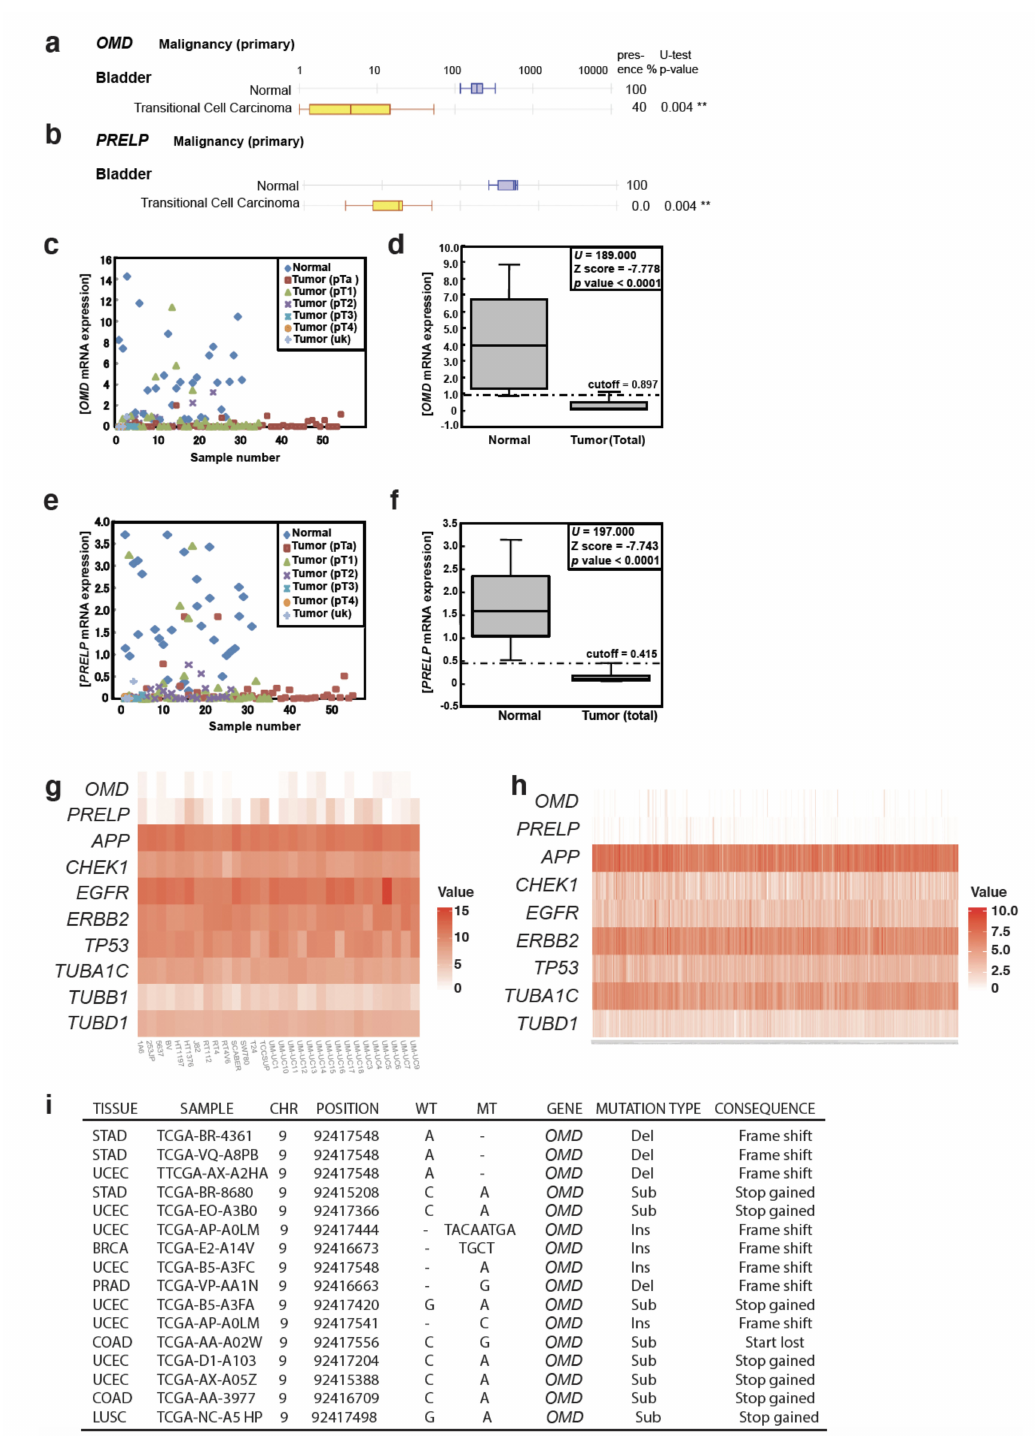
Figure 1. Expression of osteomodulin (OMD) and proline / arginine-rich end leucine repeat protein (PRELP) in cancer ( a , b ). Microarray analysis of OMD ( a ) and PRELP ( b ) expression in human bladder cancer samples and normal bladder tissues. ( c ) Quantitative analysis of OMD expression in bladder cancer at di ff erent stages by qPCR. ( d ) Box–whisker plot (median 50% boxed) of ( c ). Cuto ff value (dash line) was determined as described in Materials and Methods. ( e ) Quantitative analysis of PRELP expression in bladder cancer at di ff erent stages by qPCR. ( f ) Box–whisker plot of ( e ). ( g ) Expression analysis of OMD and PRELP in bladder cell lines. Published expression profiling data of MIBC cell lines (GSE97768) are re-examined to elucidate the relative expression of OMD and PRELP in